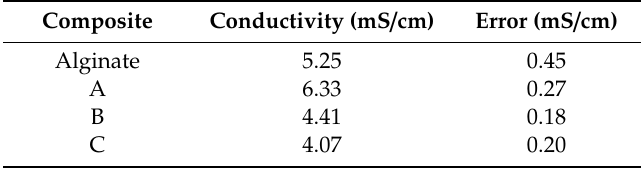
Table 1. Conductivity of cross-linked alginate and composite gels.